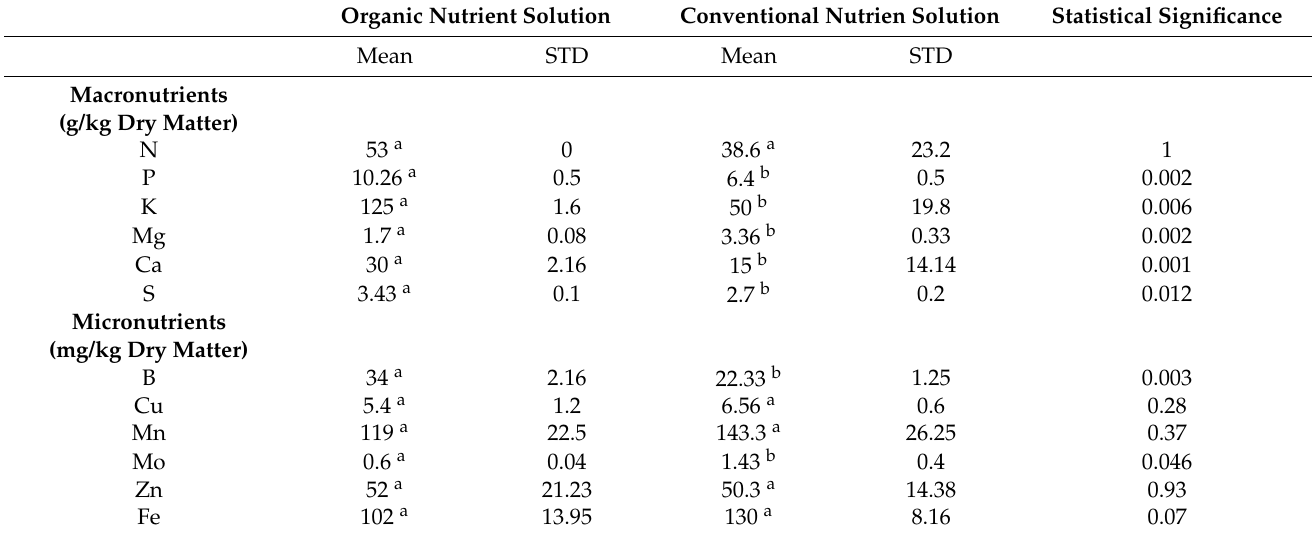
Table 4. Nutrients content in leaves of lettuce grown in the organic nutrient solution and in the conventional nutrient solution. Mean values and standard deviations (STD) are given. Statistically significant differences are indicated by different letters.